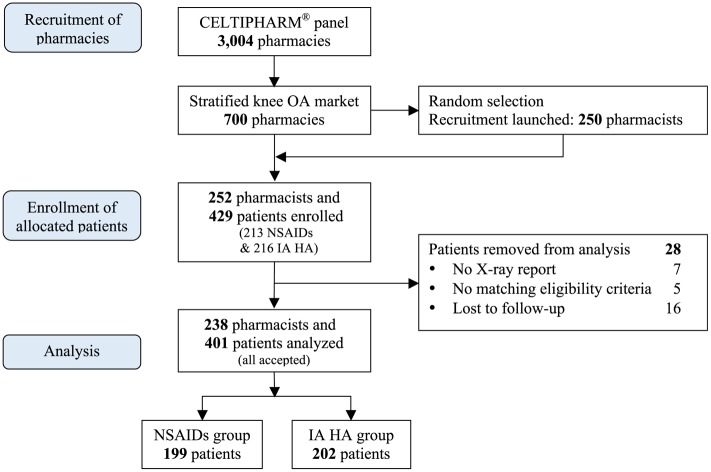
Study flow-chart.